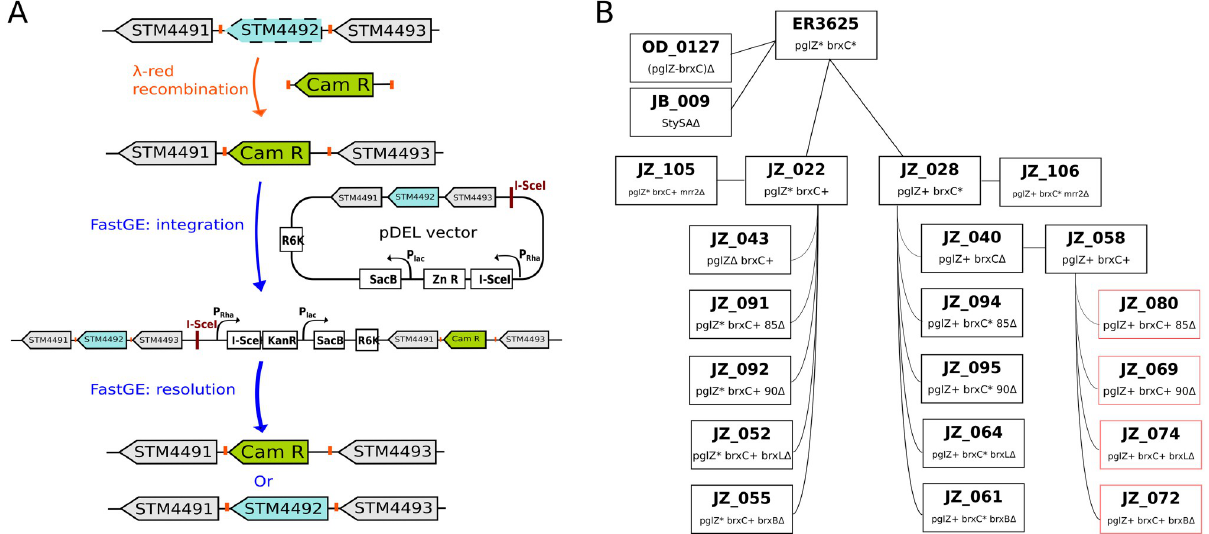
Fig 7. Engineering method and engineered strains. Panel A, Scarless engineering pipeline for replacement of mutated gene by WT. The lambda-Red recombination step is as in [89]. The integration and resolution steps are mediated by homologous recombination, with sucrose counterselection for excision [90]. Panel B, partial strain pedigree. Intermediate steps of panel A are omitted for clarity.